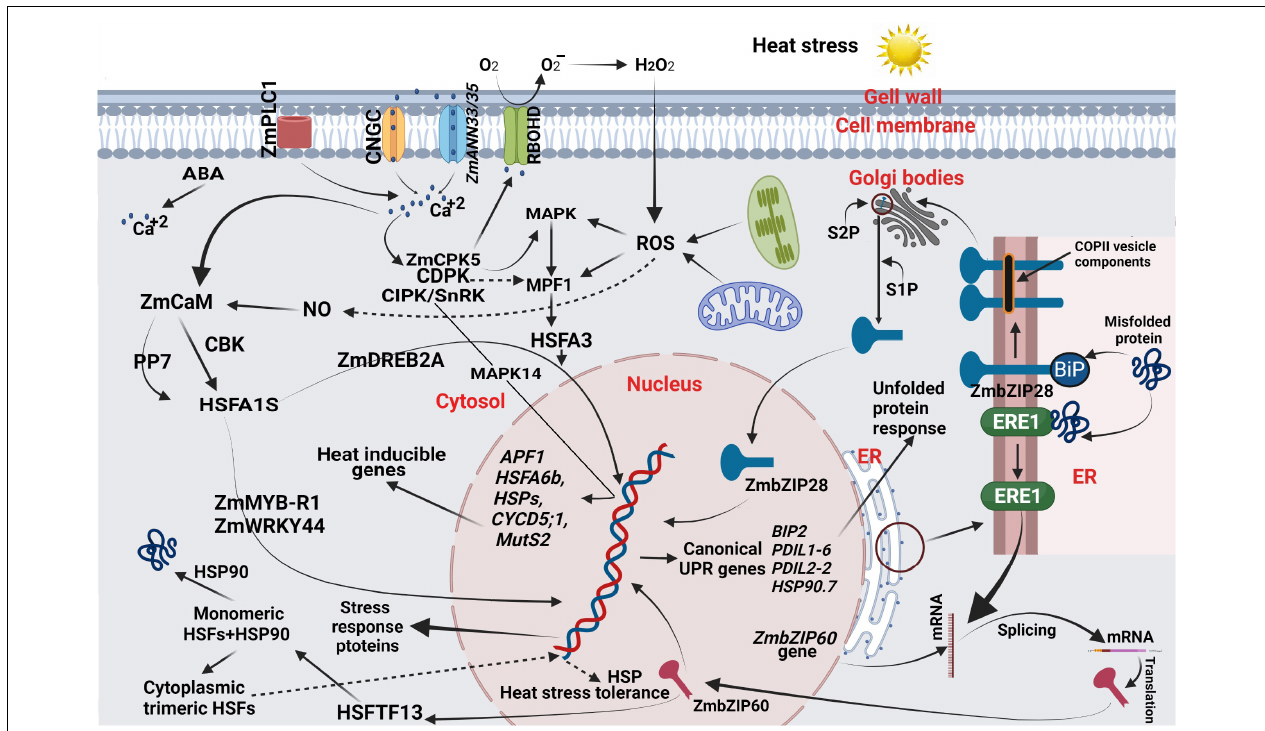
FIGURE 3 | A heat stresses responsive regulatory network in maize. Heat stress damages the cell membrane when exposed to heat stress and promotes the release of apoplastic Ca 2 + . Heat stress disturbs the plasma membrane’s fluidity and permeability, resulting in a loss in function of chloroplasts and mitochondria, higher cytosolic Ca 2 + , ROS, NO, and over-accumulation of misfolded or unfolded proteins. Increased cytosolic Ca 2 + , ROS, and NO are secondary messengers and stimulate downstream regulatory networks. Heat stress disrupts protein homeostasis, inducing unfolded-protein response (UPR) and signaling pathways mediated by IRE1- ZmZIP60 and ZmZIP28 . The ZmZIP60 activates the expression of a type-A HSF and HSFTF13 , which upregulates the expression of HSP genes, i.e., Hsp90 . The Ca 2 + signaling is essential in heat tolerance of seed-set in maize under field conditions, where calcium, a critical secondary messenger, converges signals transmitted from high temperature, membrane fluidity, calcium efflux, and ABA (among others), amplifying them through the activation downstream of genes, such as HSFA6b , ABF1 , CYCD5 ;1, MutS2 , and HSPs during reproductive stage via the MAPK pathway, and eventually enhance maize tolerance to heat stress for seed-set. This figure was made using